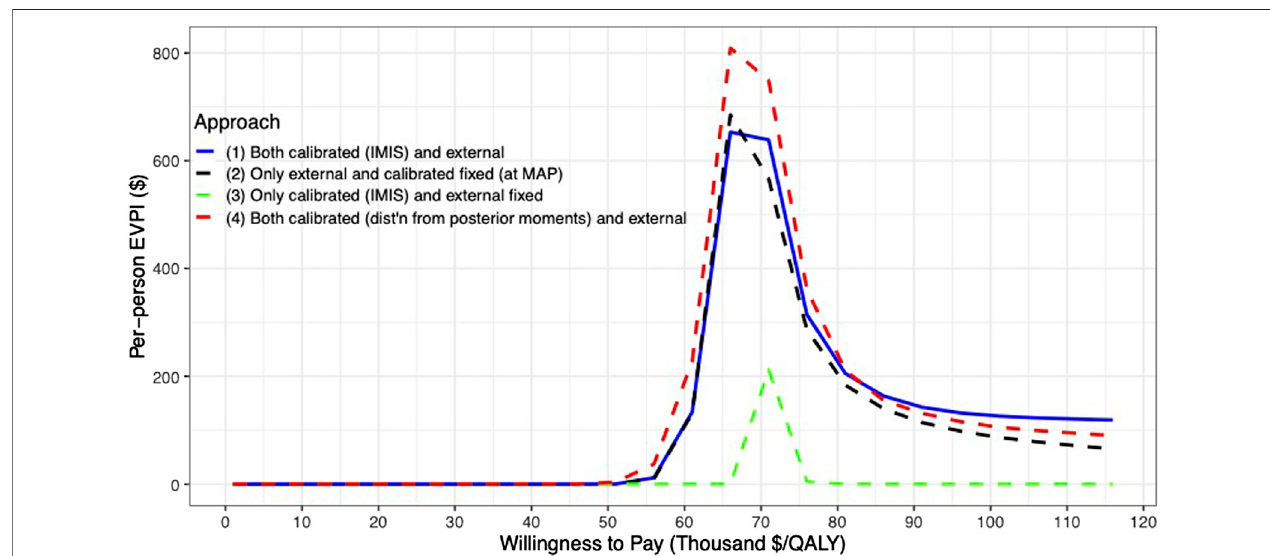
FIGURE 6 | Per-patient EVPI of 10-year colonoscopy screening vs no screening under different approaches to characterize the uncertainty of both the calibrated and external parameters.